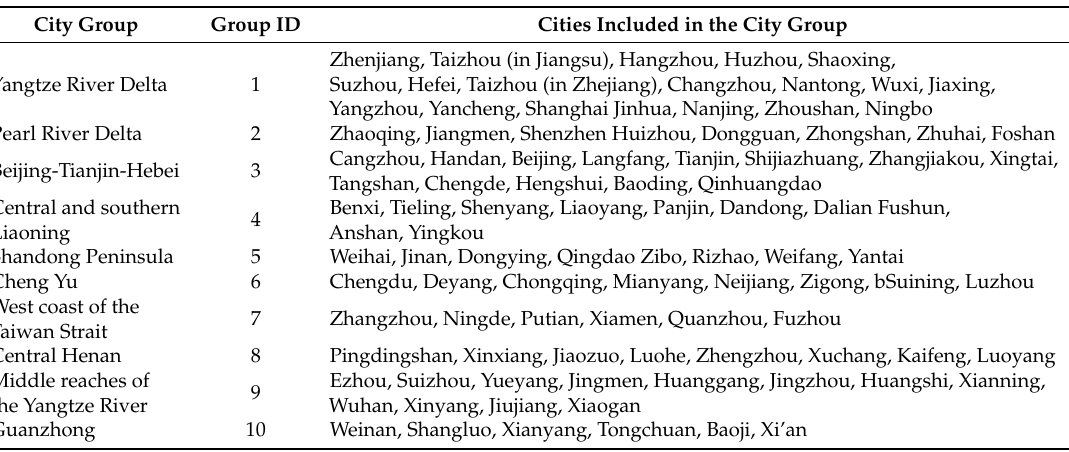
Table 1. The city group classification of the ten major city groups in